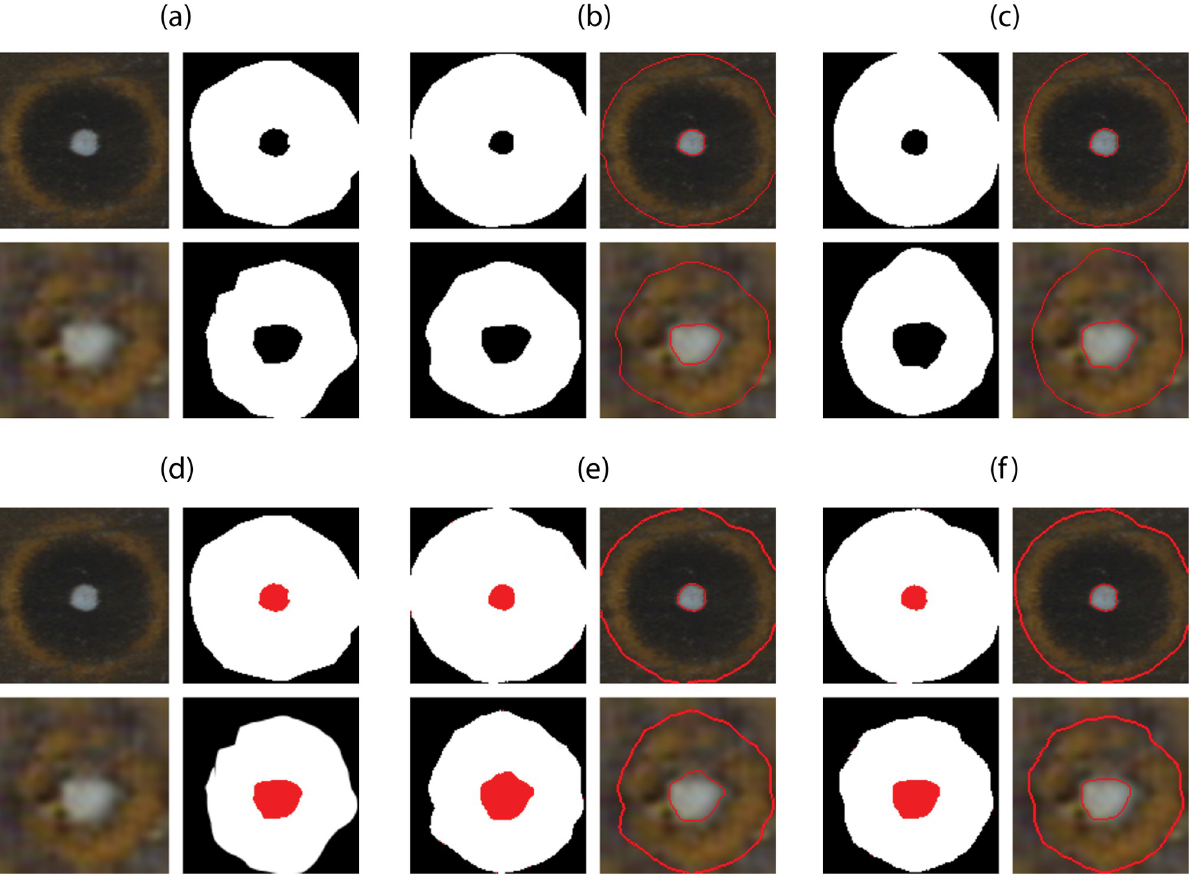
Fig 5. Example of U-Net segmentation results using different number of classes and cost functions. (a) Original RGB eyespot image and its two- class ground truth segmentation, (b) Predicted segmentation using CE loss function and corresponding contours. (c) Predicted segmentation using weighted CE loss function and corresponding contours. (d) Original RGB eyespot image and its ground truth segmentation, (e) Predicted segmentation using CE loss function and corresponding contours. (f) Predicted segmentation using weighted CE loss function and corresponding contours.